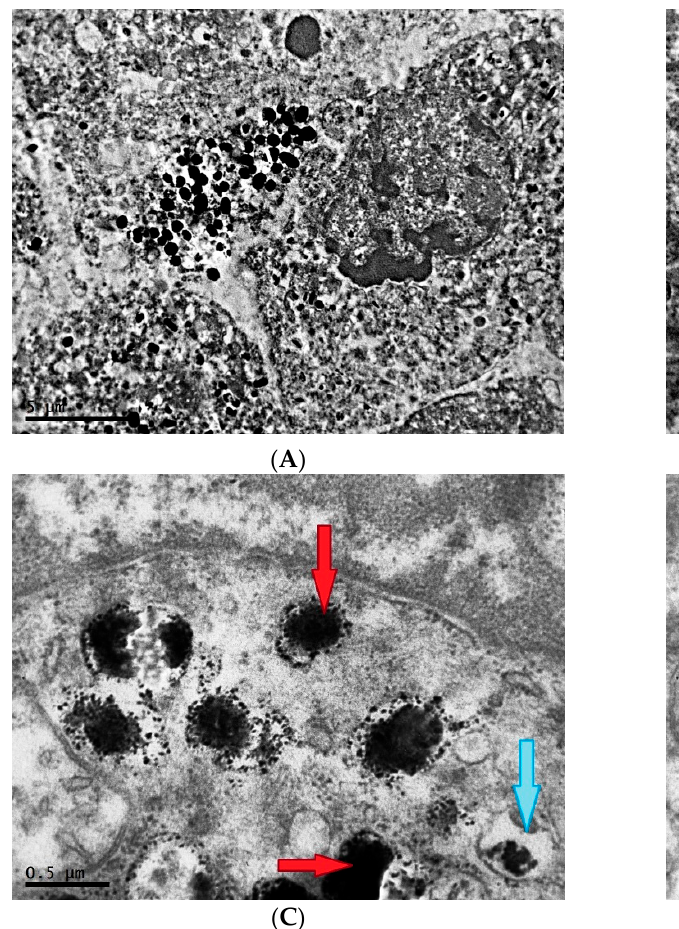
Figure 2. Organelles of cells of transplantable malignant melanoma B16 under the influence of